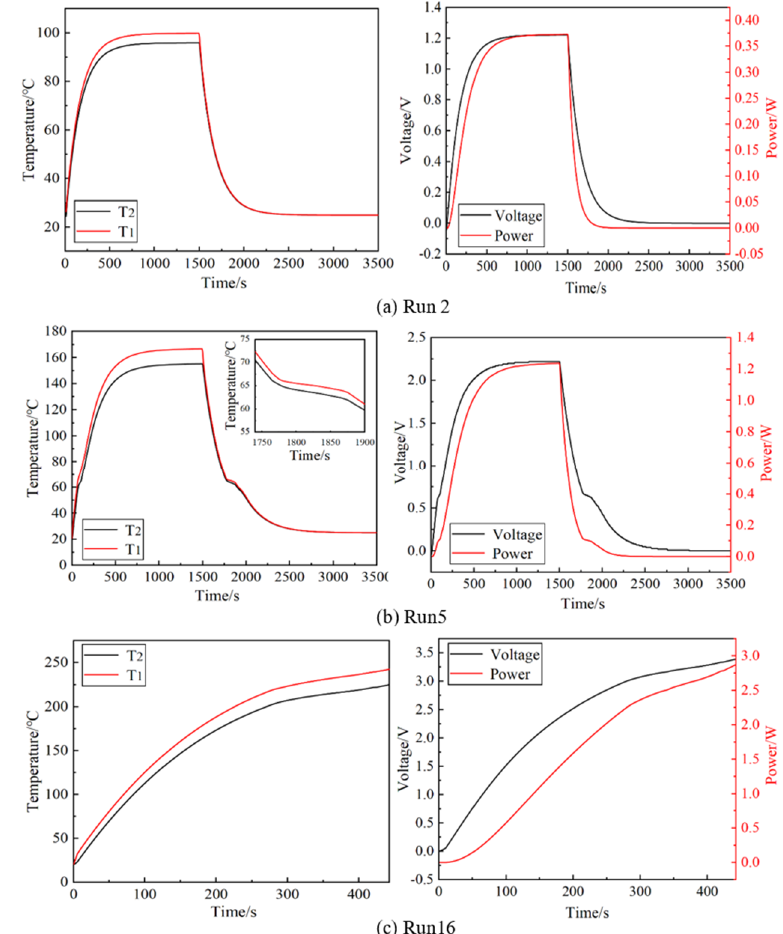
Figure 7. Thermoelectric performance of the TEG system.